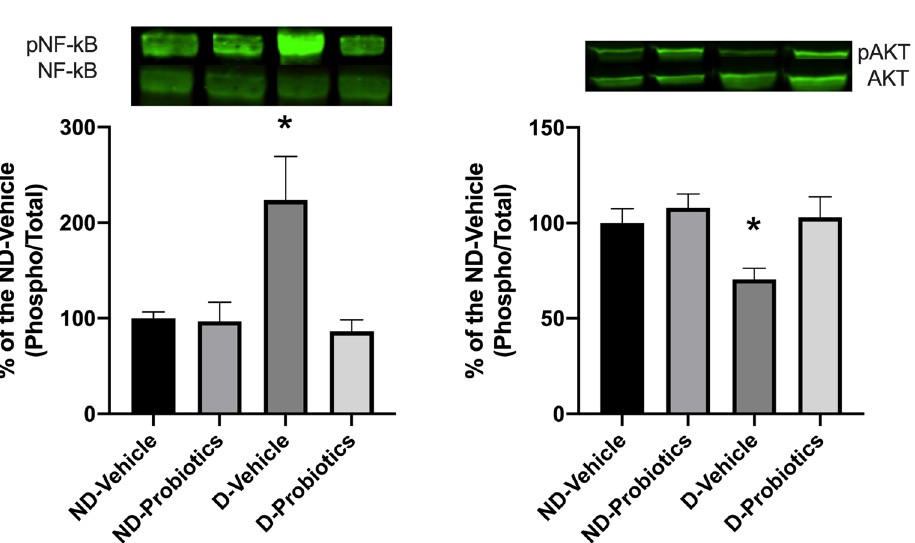
Figure 4. Left panel: p-NF-kB/NF-kB ratio right panel: p-Akt/Akt ratio. Results are expressed as a percentage of the ND-vehicle group in the myocardial ischemic region assessed by in vitro western blotting after 15 min of reperfusion. * indicates a significant interaction between the main factors (p < 0.05; Diet and Probiotics). Bands are cropped from original western blots presented in supplementary information file: Fig.